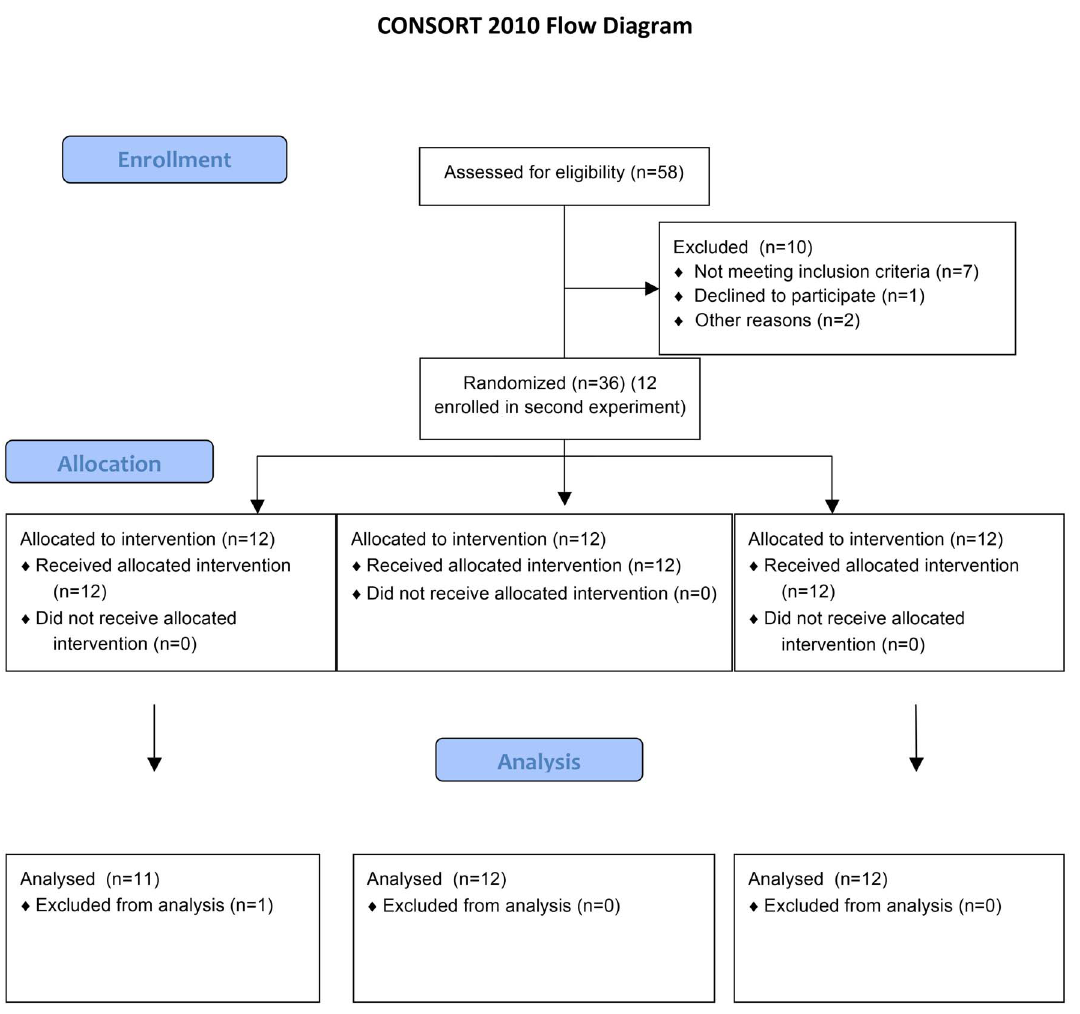
Figure 1. CONSORT Flowchart.